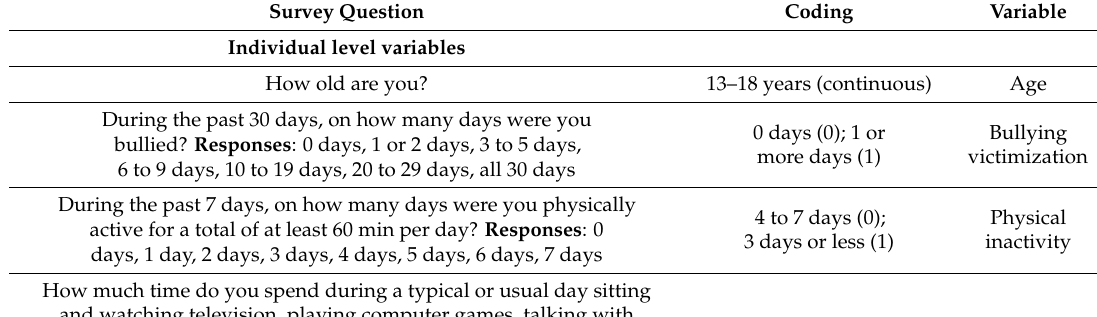
Table 1. Independent variable derivation from the GSHS survey data in Kuwait 2015.